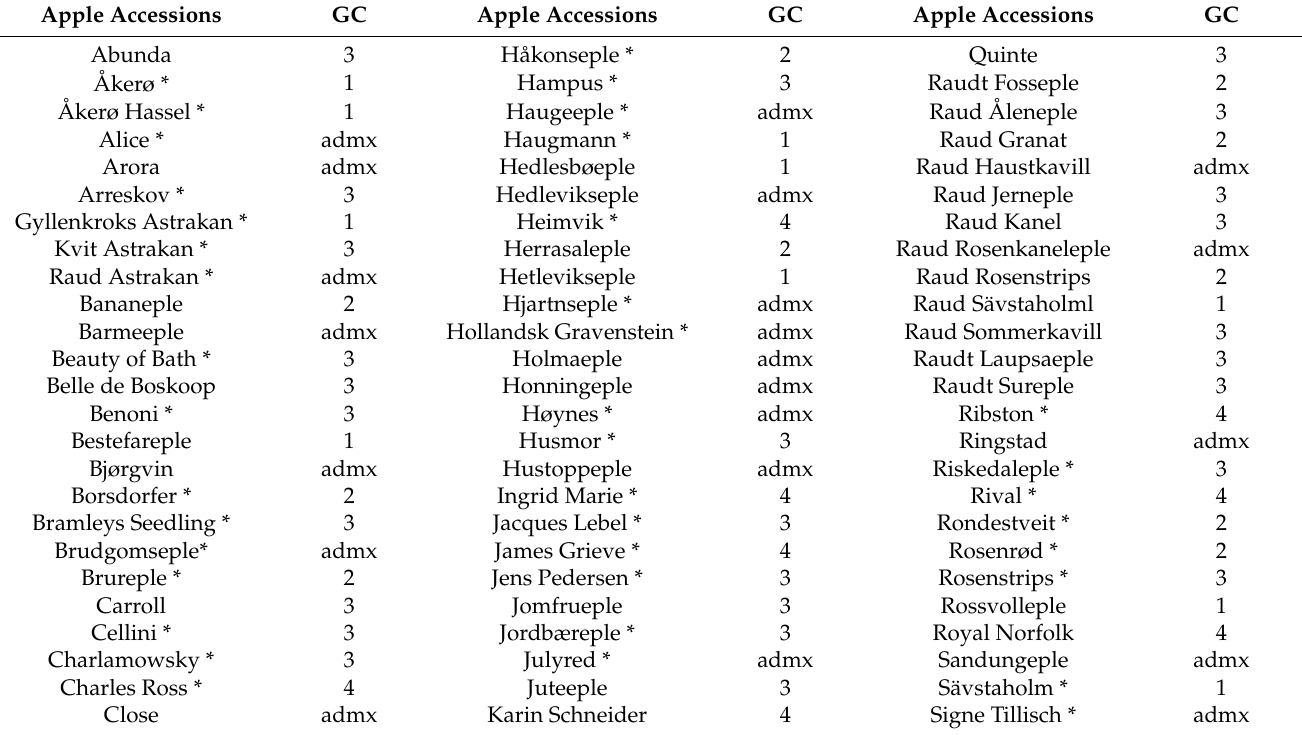
Table 1. A total of 171 apple accessions conserved in Ullensvang, western Norway, analyzed using 20 SSR markers, as well as assignment of each non-admixed genotype to a genetic cluster (GC) (K = 4) defined by Structure [32] (probability of membership qI >